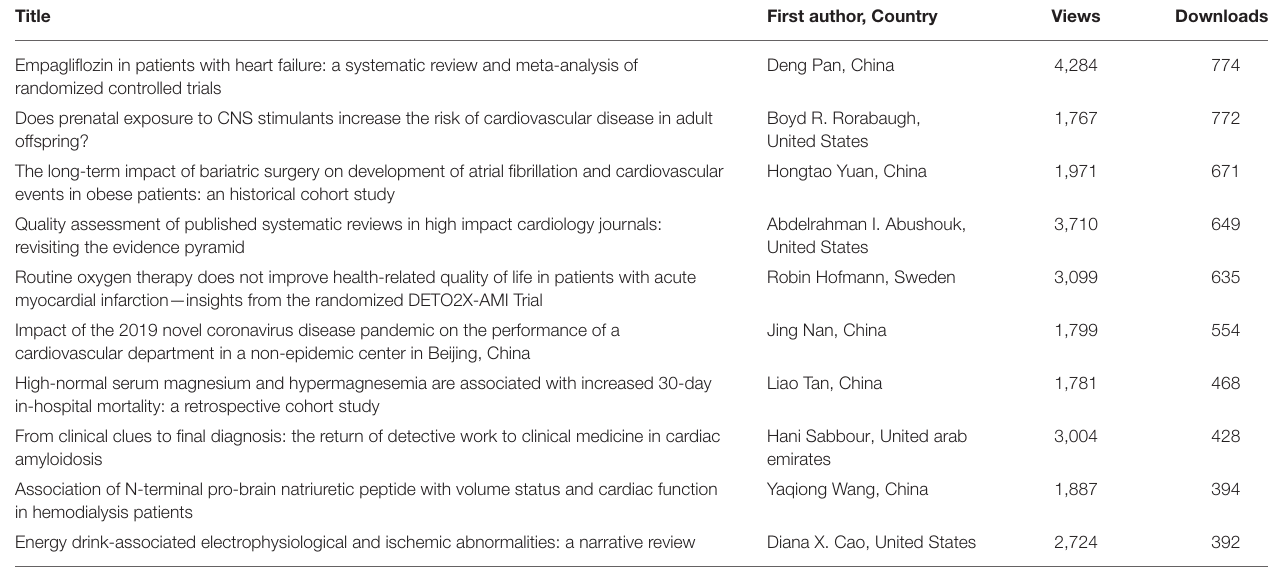
TABLE 1 | Metrics (on April 21st 2022) of the highlight’s articles published in Frontiers in Cardiovascular Medicine, General Cardiovascular Medicine section, in